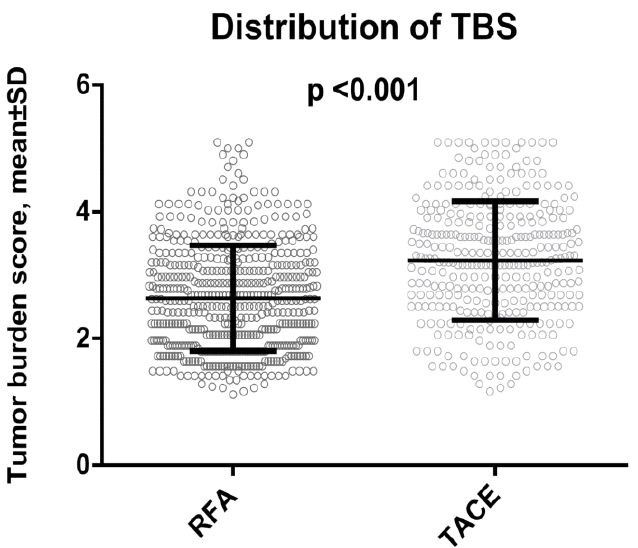
Figure 1. Data distribution of tumor burden score (TBS) in hepatocellular carcinoma patients within the Milan criteria undergoing radiofrequency ablation (RFA) and transarterial chemoembolization. TACE group had a significantly higher TBS compared with RFA group ( p < 0.001). Table 1. Comparison of baseline demographics of patients with HCC within Milan criteria under-